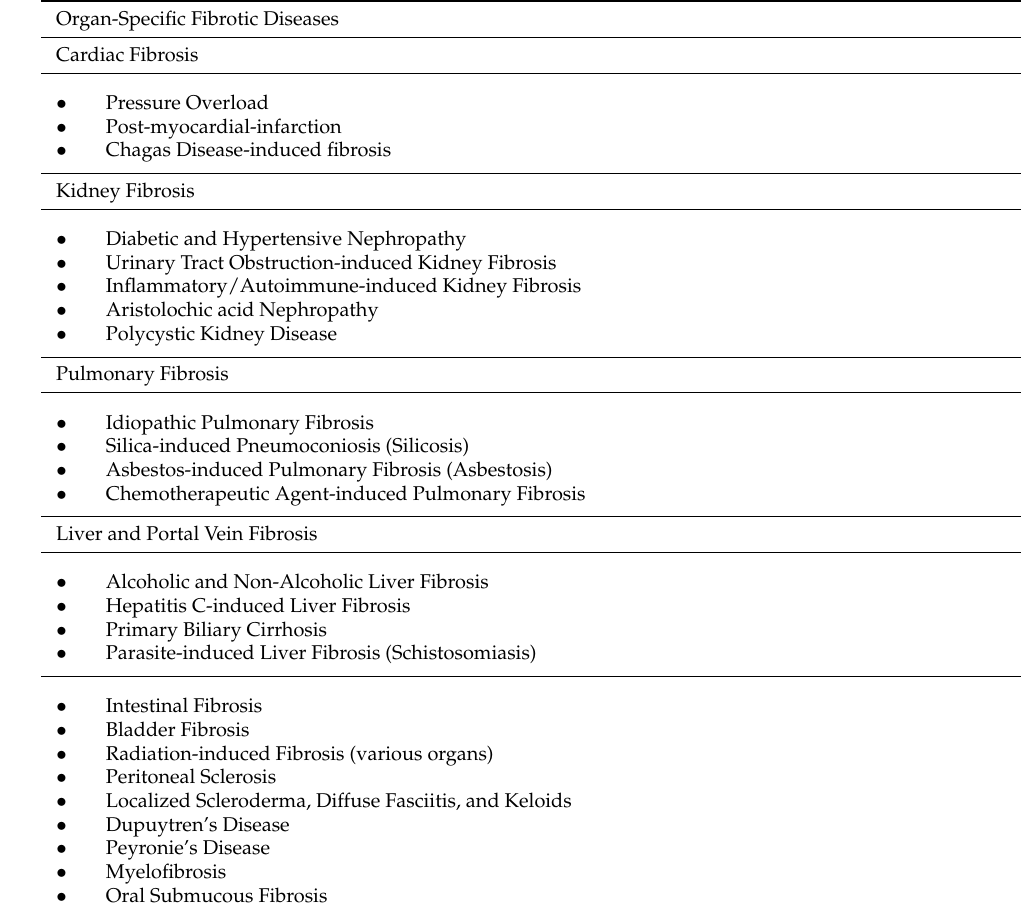
Table 1. Common human fibrotic diseases (adapted from Piera-Velazquez et al.